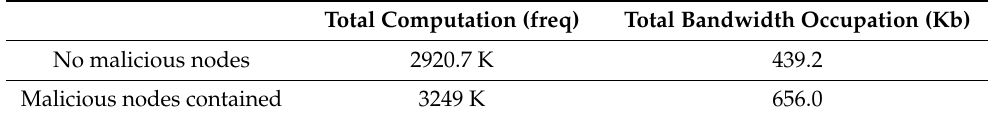
Table 5. The performance of the RIPPLE algorithm.